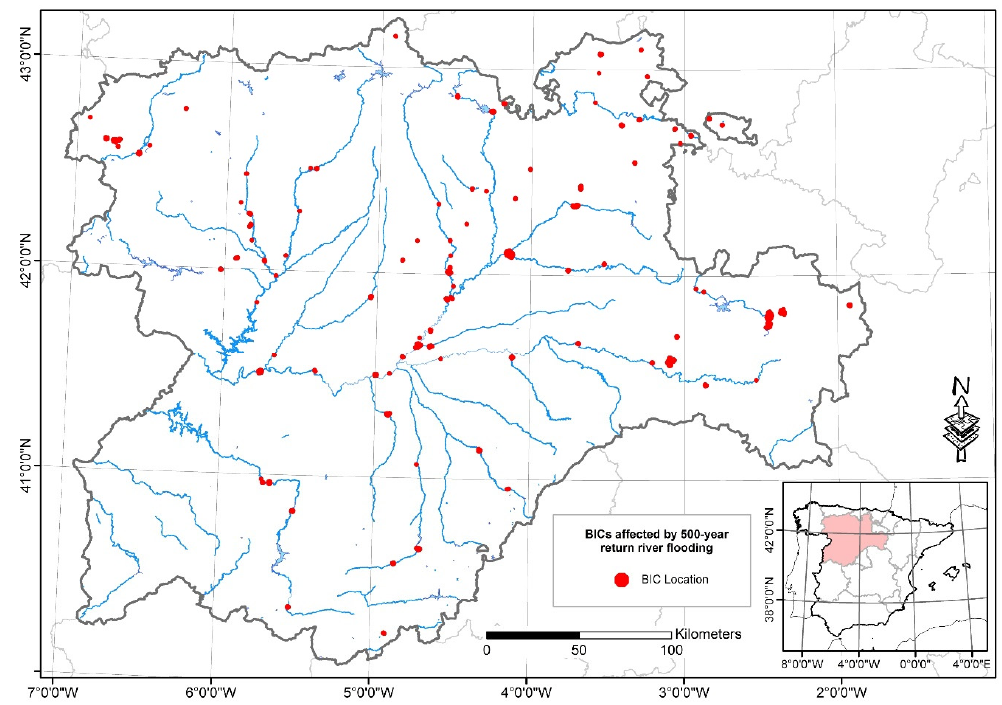
Figure 1. BICs location map for Castile and León region.